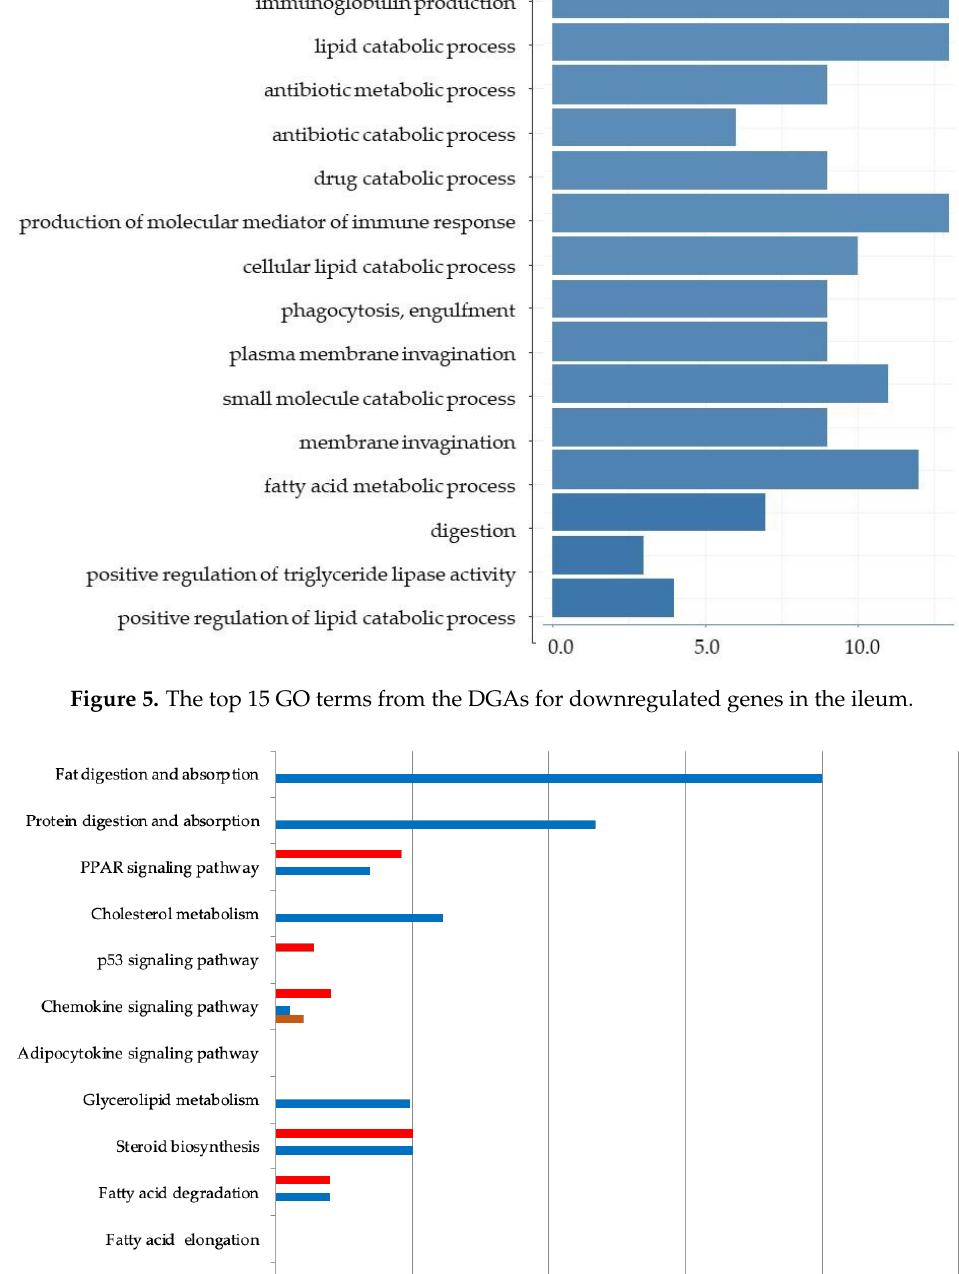
Figure 4. The top 15 GO terms from the DGAs for upregulated genes in the ileum.